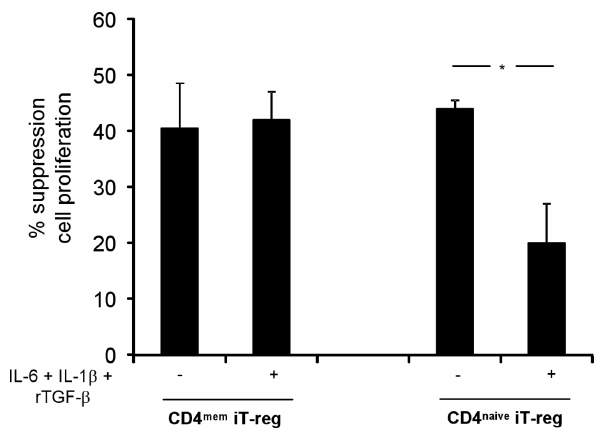
Figure 1. Suppressor ability of iT-reg derived from CD4 + CD45RO + memory (CD4 mem ) and from CD4 + CD45RA + naı¨ve (CD4 naive ) cells. The ability of iT-reg obtained from CD4 mem and CD naive -derived Th17 cells was evaluated after 4-day co-culture by 3 H-thymidine incorporation in 5 healthy subjects. Mean ( + SEM) percentage suppression of CD4 effectors by CD4 mem or CD4 naive iT- reg before and after exposure to IL-6, IL-1 b and rTGF- b . CD4 mem but not CD4 naive iT-reg maintain their suppressor ability after exposure to Th17 driving cytokines. * P # 0.05.